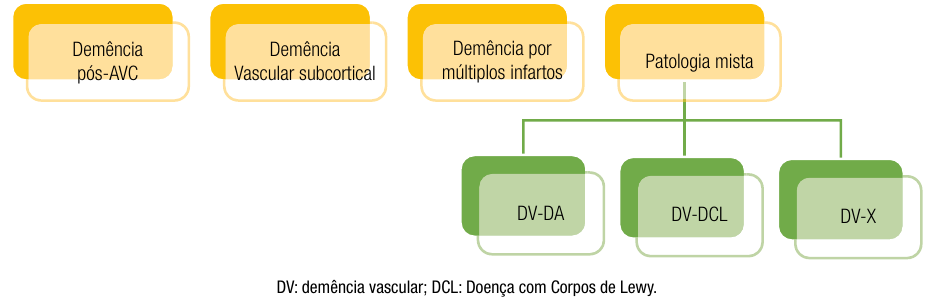
Figura 3. Classificação das formas de demência vascular segundo o VICCCS (Vascular Impairment of Cognition Classification Consensus Study) (1). Cada forma será ainda estratificada em possível e provável (Tabela 3). As formas mistas podem ocorrer em todas as síndromes acima, devendo ser detalhadas quanto à